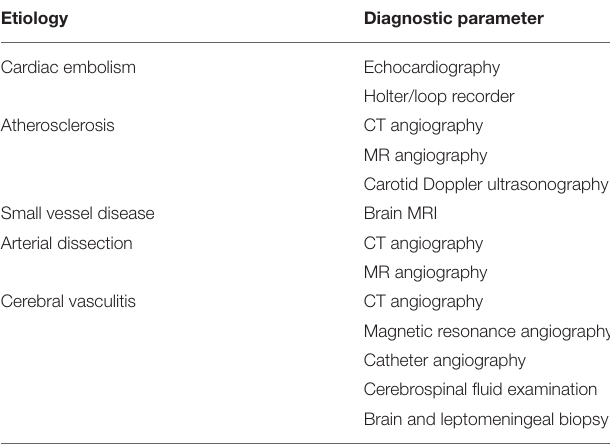
TABLE 1 | Etiology and parameters in diagnosis of